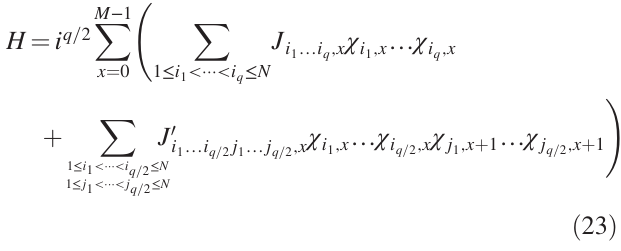
for G εε (black circles) and k ¼ 19 . 2 ð T= μ Þ 1 . 50 and k